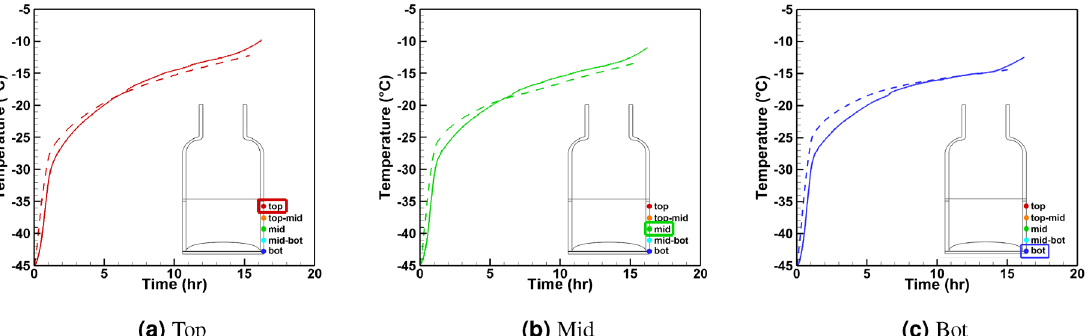
Figure 11. Temperature sensing elements readings vs. virtual thermocouple reading at the vial walls and inside the vial during primary drying stage for three sensors at the center vial #7 (schematic position of the vial is shown in Fig. 8b).